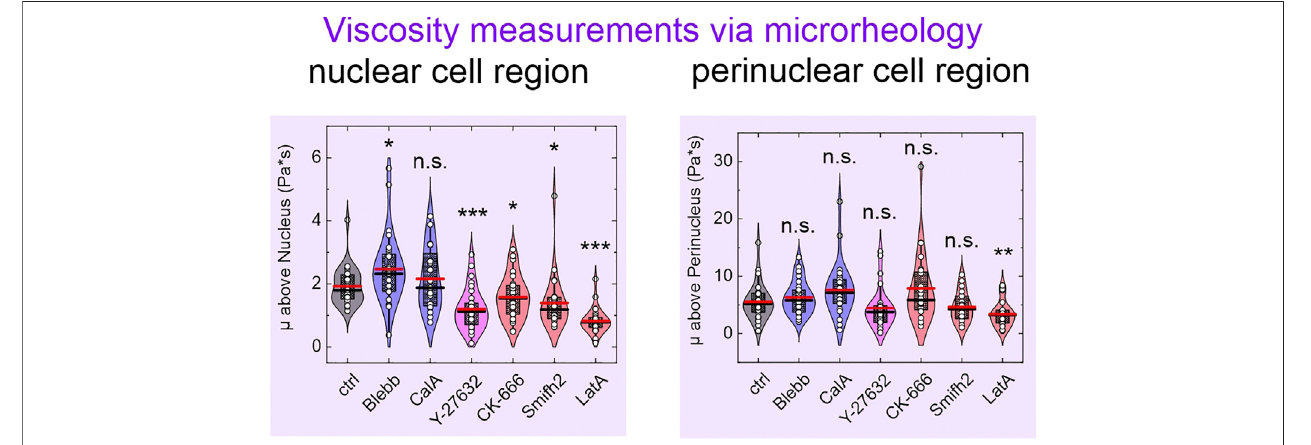
FIGURE 4 | Viscosity μ as an additional parameter obtained from oscillatory microrheology tests at the nucleus and at the perinuclear region.